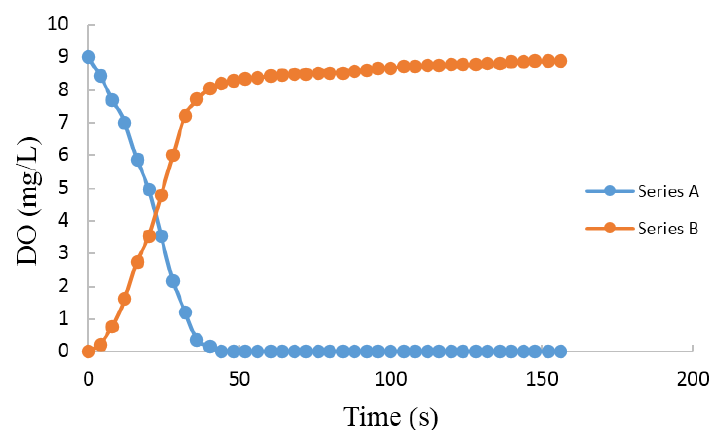
Figure 11. Speed Test.